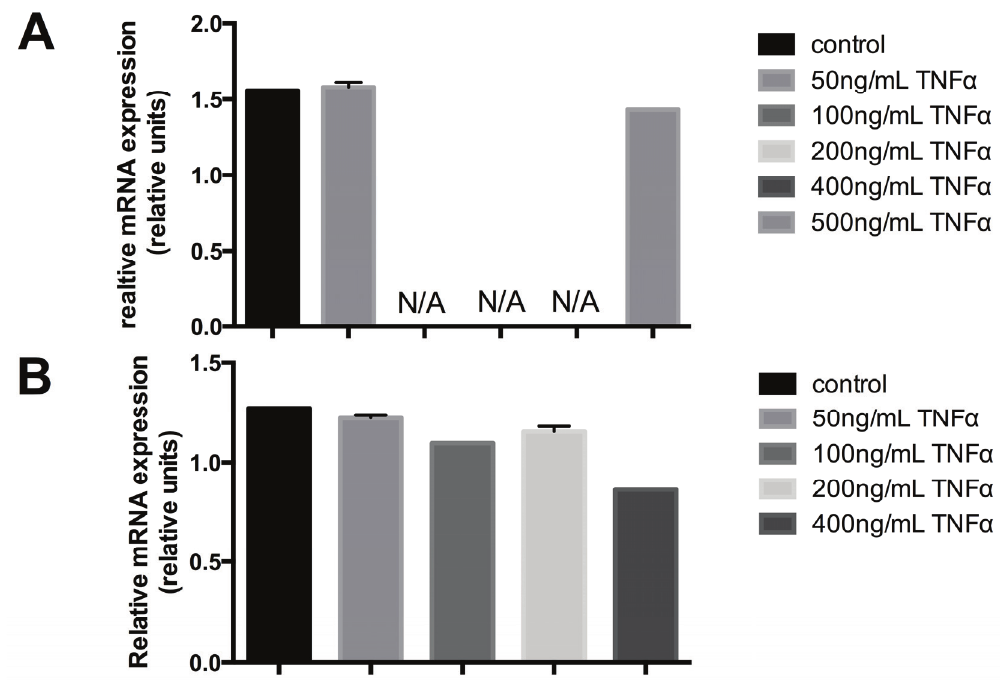
Figure 1. ( A ) PTPIP51 mRNA expression in untreated human keratinocytes and in TNF(cid:3) treated cells (50 ng/mL, 500 ng/mL). The expression is given in relative units. N/A: not measurable. ( B ) RelA mRNA expression in untreated human keratinocytes and in